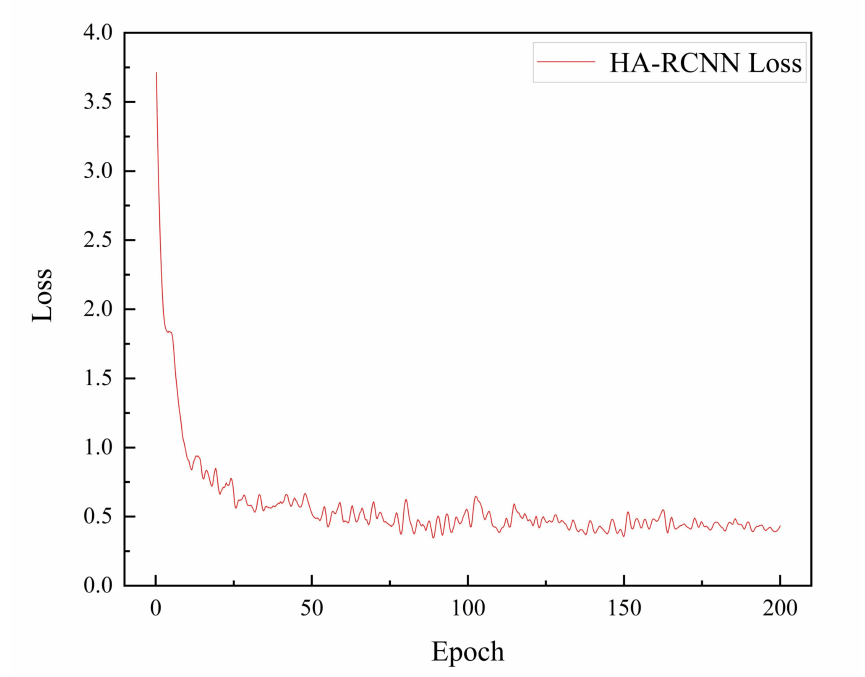
Figure 6. Loss curve of